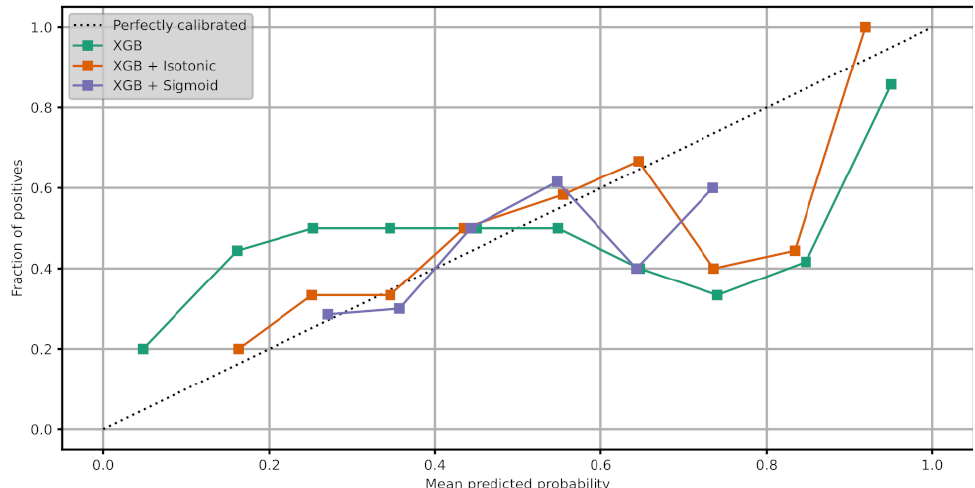
Figure 9. Calibration plot of XG Boost classifier for class 0.